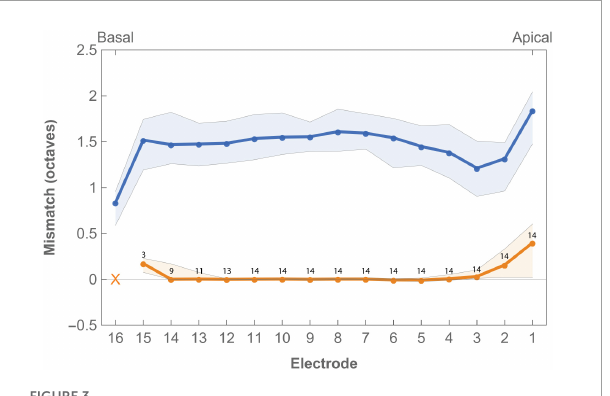
FIGURE3 Median frequency-to-place mismatch in octaves across the electrode array for imaging-based (orange) and standard (blue) fitting. Digits indicate the number of subjects in which the electrode was enabled in imaging-based fitting. Electrode 16 was disabled in all imaging-based maps as tonotopic location of this contact was always greater than the highest frequency covered by the CI. Virtual channel not included in graph. Error bands indicate first and third